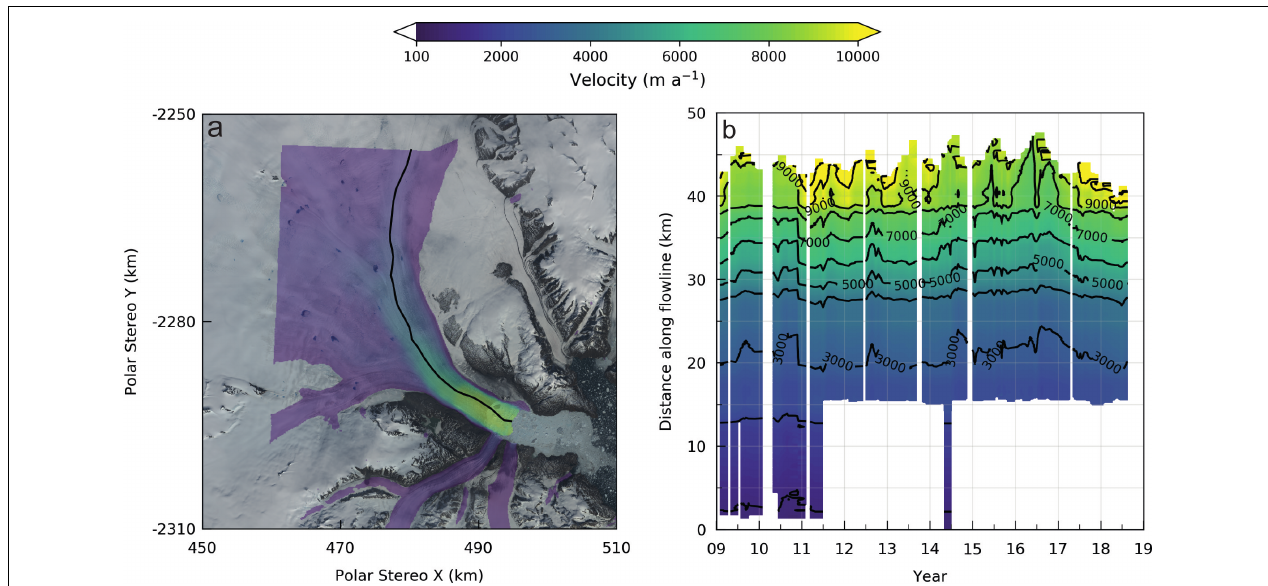
FIGURE 4 | InSAR derived down-glacier velocity profiles for Kangerlussuaq between 2009 and 2018. (a) Mean glacier velocity between 2009 and 2018. (b) Contour plot of down-glacier velocity profile for center line shown in (a) . For visualization purposes, and to obtain a more complete velocity record that accounts for irregular sampling intervals, velocity was linearly interpolated in time if the observation intervals are shorter than 66 days (i.e., six repeat pass cycles). Background image is Landsat 8 scene from 07 July 2017 (path 230 and row